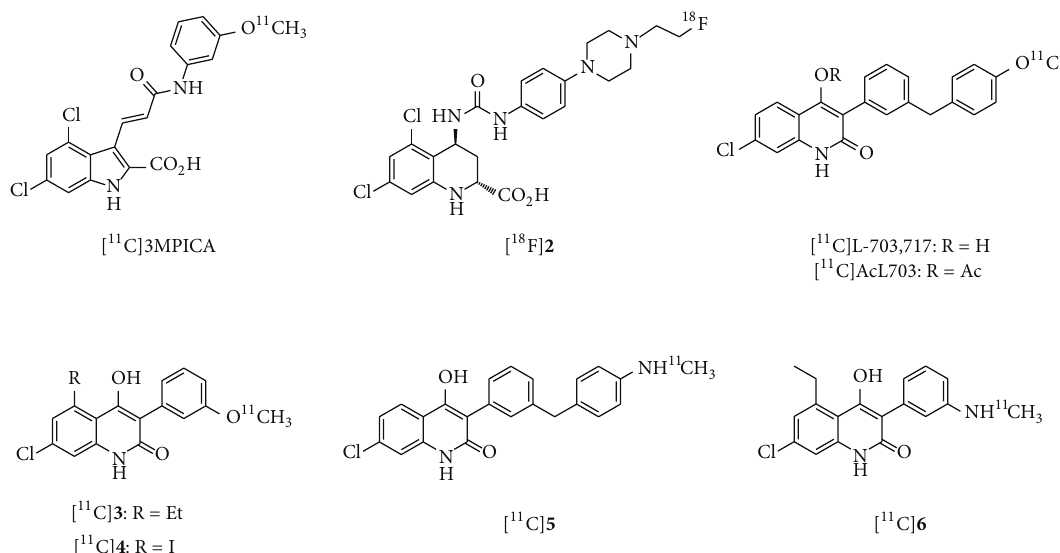
Figure 3: Chemical structure of imaging probes for glycine binding site of